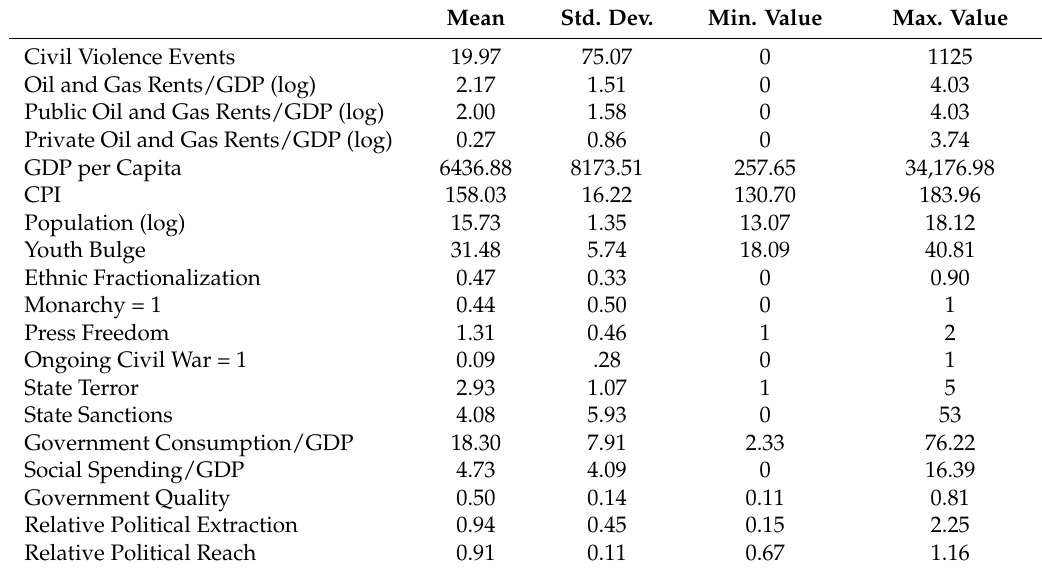
Table 1. Descriptive Statistics of All